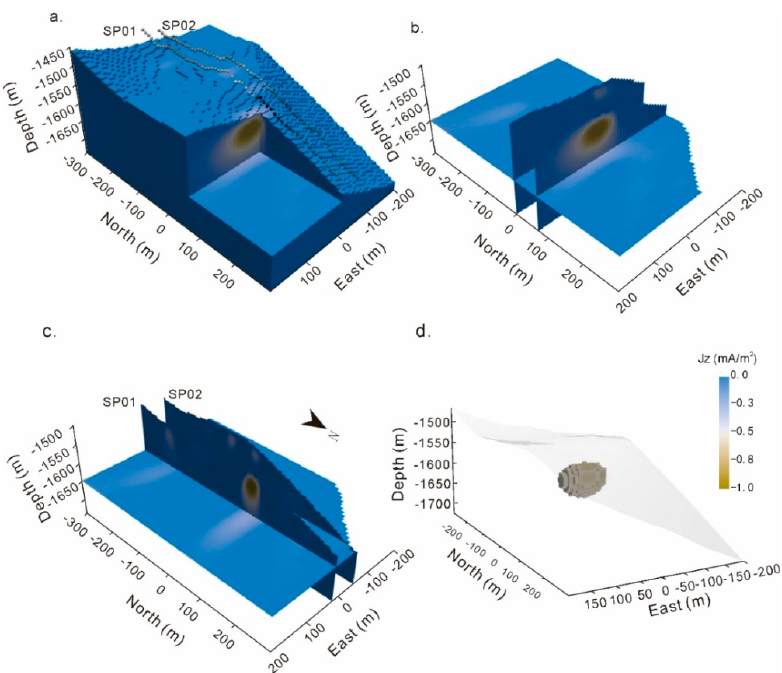
Figure 36. Self ‐ potential tomography of self ‐ potential data. The tomography is performed in terms of the causative source ‐ current ‐ density distribution below the seafloor. ( a ) Inverted source ‐ current ‐ model distribution. The black dots denote the positions of the electrodes in the seawater. ( b ) Cross ‐ sections along east–west with y = 0 m and y = 70 m. ( c ) Tomography of the inverted source ‐ current ‐ density distribution below Profiles SP01 and SP02. ( d ) Inferred ore body shape from the inverted data (domain where the magnitude of current density is lower than − 0.5 mA m − 2 ). Note that the lateral extension of the ore body is limited by the self ‐ potential dataset that is acquired only along two parallel lines (modified from [115]).